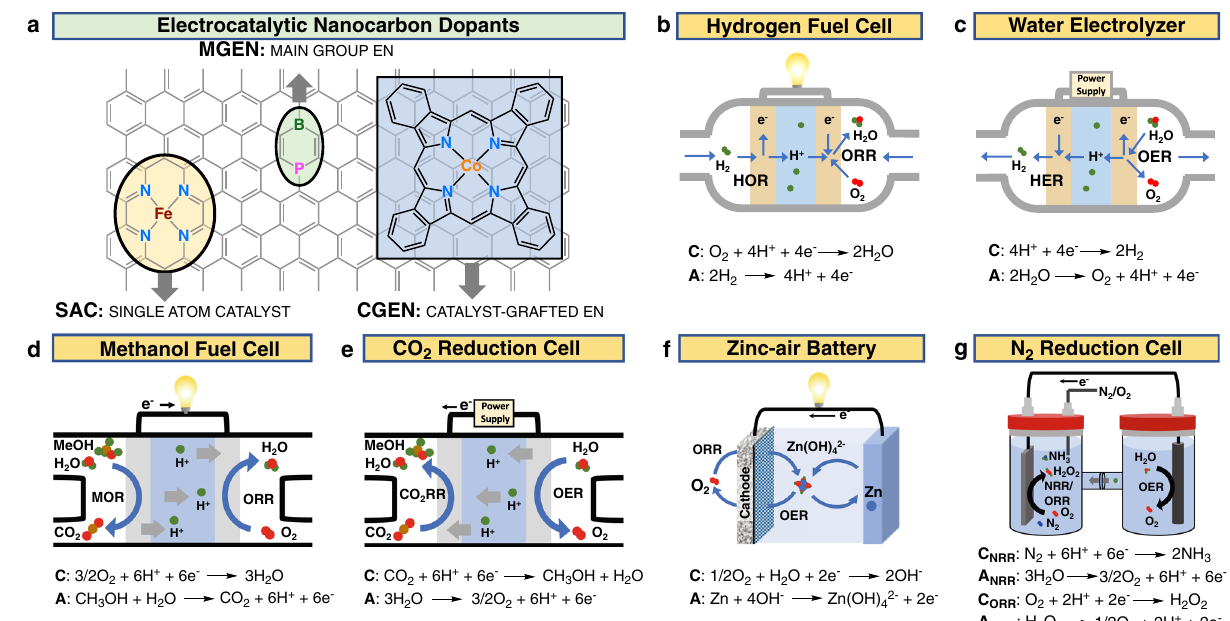
Fig. 1 Structures of electrocatalytic nanocarbons and schemes of electrochemical devices. a Representative structures of the three EN types. Hydrogen fuel cell ( b ) and water electrolyzer ( c ) where EN is incorporated to accelerate the ORR, OER, and HER. A methanol fuel cell ( d ) and CO 2 reduction cell ( e ) which make use of EN for the MOR, CO 2 RR, ORR and OER. A zinc-air battery ( f ) where EN functions as a cathode electrocatalyst for the ORR and OER. A nitrogen reduction or oxygen reduction cell ( g ) where EN is being investigated for the NRR and 2e − ORR for electrochemical production of ammonia and hydrogen peroxide,